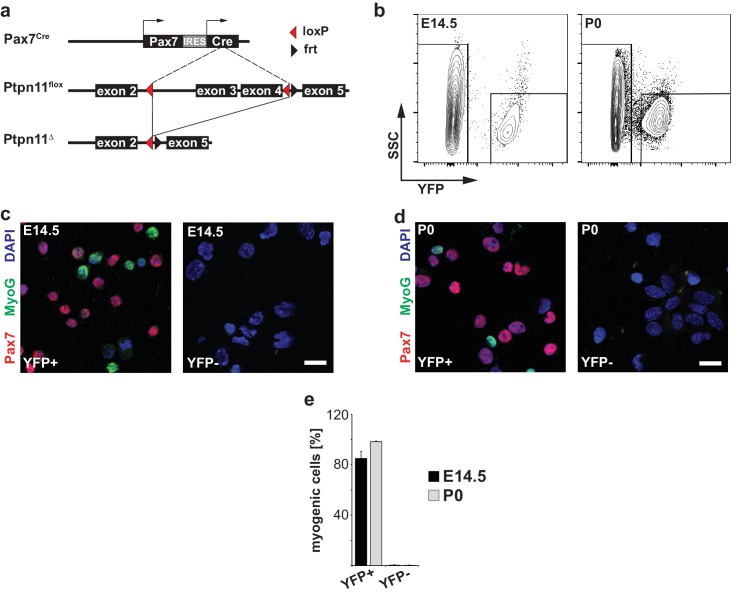
Genetic strategy used to mutate Ptpn11 and isolation of myogenic stem cells.(a) Genetic strategy used to mutate Ptpn11 using Pax7Cre and Ptpn11flox alleles. (b) Gating strategy to isolate YFP+ and YFP- cells from E14.5 and P0 Pax7Cre;RosaeYFP animals by FACS. YFP fluorescence and side scatter (SSC) are shown on the x- and y-axis, respectively. (c,d) Staining for Pax7 (red), MyoG (green) and DAPI (blue) of freshly isolated YFP+ and YFP- cells by FACS at E14.5 (c) and P0 (d). (e) Quantification of cells expressing Pax7 or MyoG in the YFP+ and YFP- population at E14.5 and P0. Error bars show S.E.M. Scale bar: 20 µm.